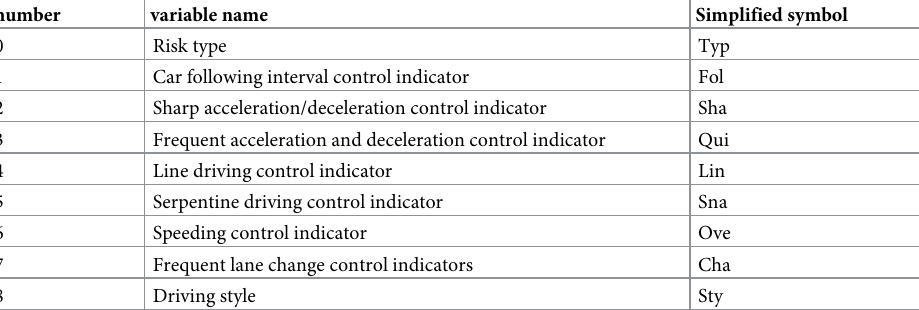
Table 5. Node variable symbol